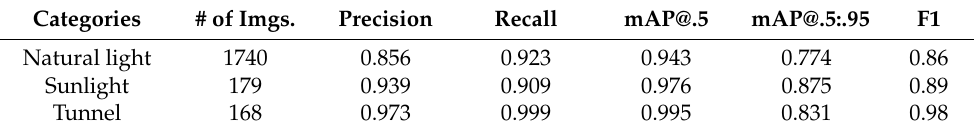
Table 6. Comparison of the recognition performance in the different types of light.